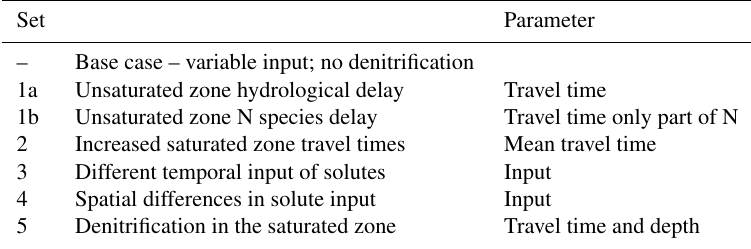
Table 2. Exploration of the model behaviour under different scenarios. Set Parameter – Base case – variable input; no